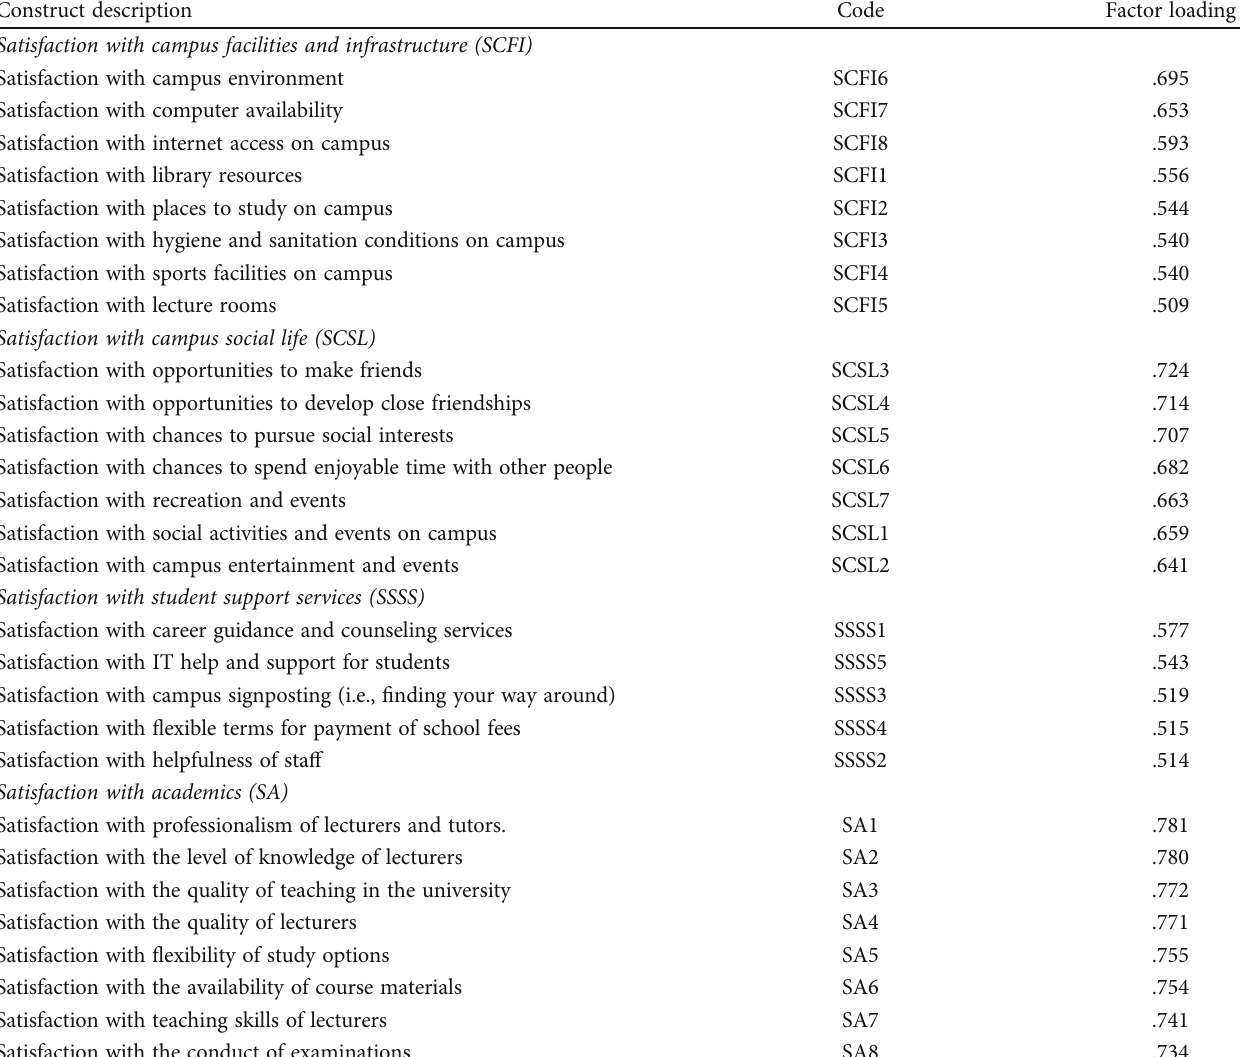
Table 3: Construct description and factor loadings.